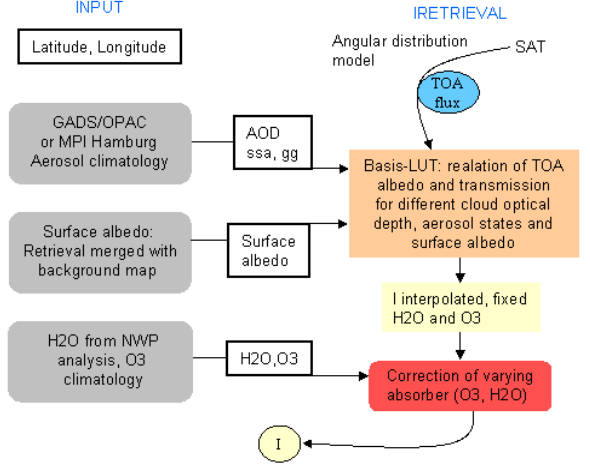
Fig. 9. Diagram of the calculation of the surface solar incoming radiation for all-sky conditions. The required input data is shown on the left side of the diagram; the right part represents the calculation of the surface solar irradiance using the look-up tables for the TOA albedo. The figure is taken from Mueller et al. (2009).